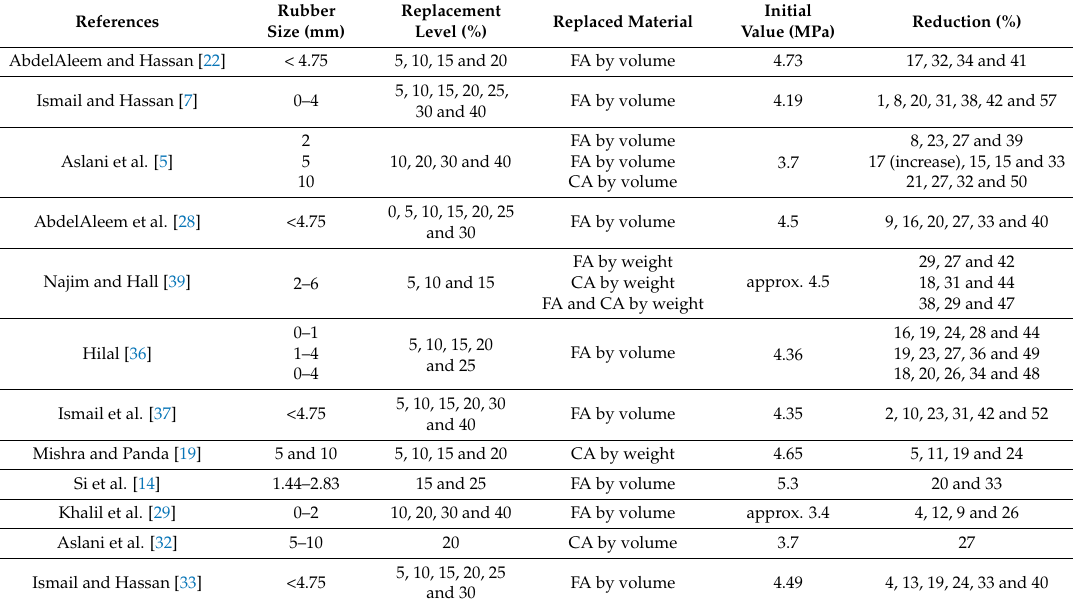
Table 5. Influence of rubber size, replacement level and replaced material on 28-days splitting tensile strength of